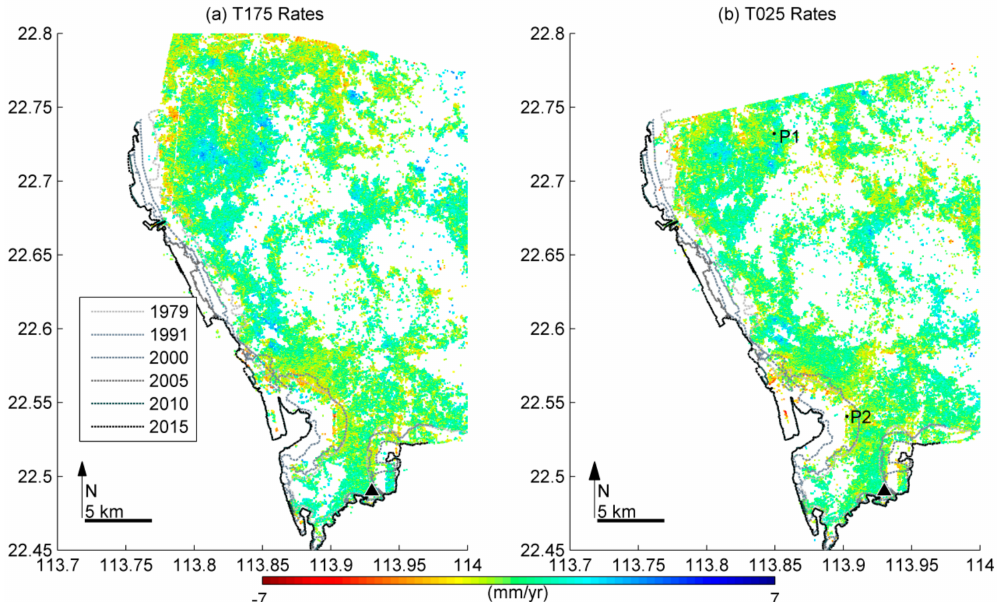
Figure 4. ( a ) Mean rates derived from InSAR time series of ASAR T175 between 21 November 2004 and 4 April 2010; ( b ) Mean rates from ASAR T025 between 6 September 2006 and 17 February 2010. Coastlines extracted from Landsat images in 1979, 1991, 2000, 2005, 2010 and 2015 are displayed in grey, light slate grey, slate grey, dim grey, dark slate grey, and black dashed lines respectively. Two points P1 and P2 are marked here for time series analysis. Reference points for ASAR T175 and T025 datasets are shown in black